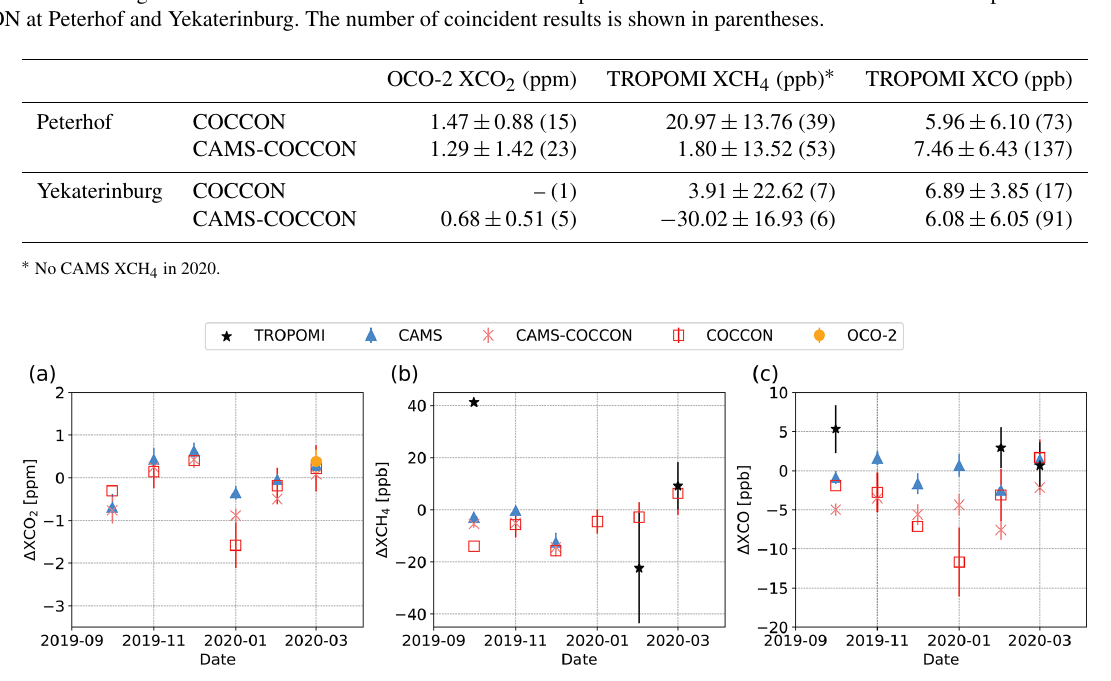
Figure 21. Monthly mean of gradients for different gases ( (cid:49) Xgas) between Peterhof and Yekaterinburg (Peterhof–Yekaterinburg) for differ- ent products. The error bars are calculated based on the standard deviation at two